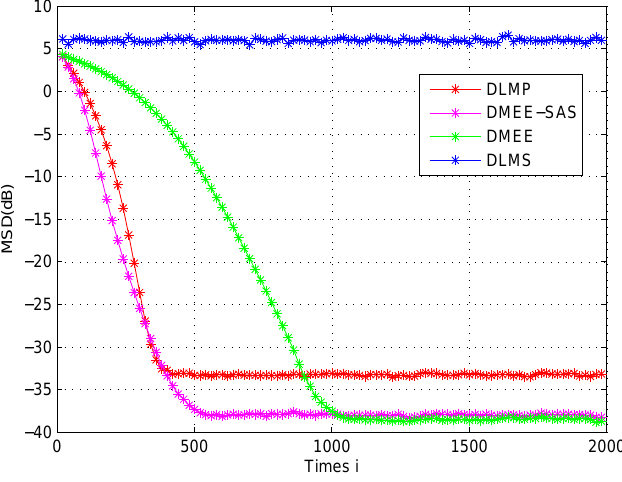
Figure 2. Transient mean-square-error (MSD)